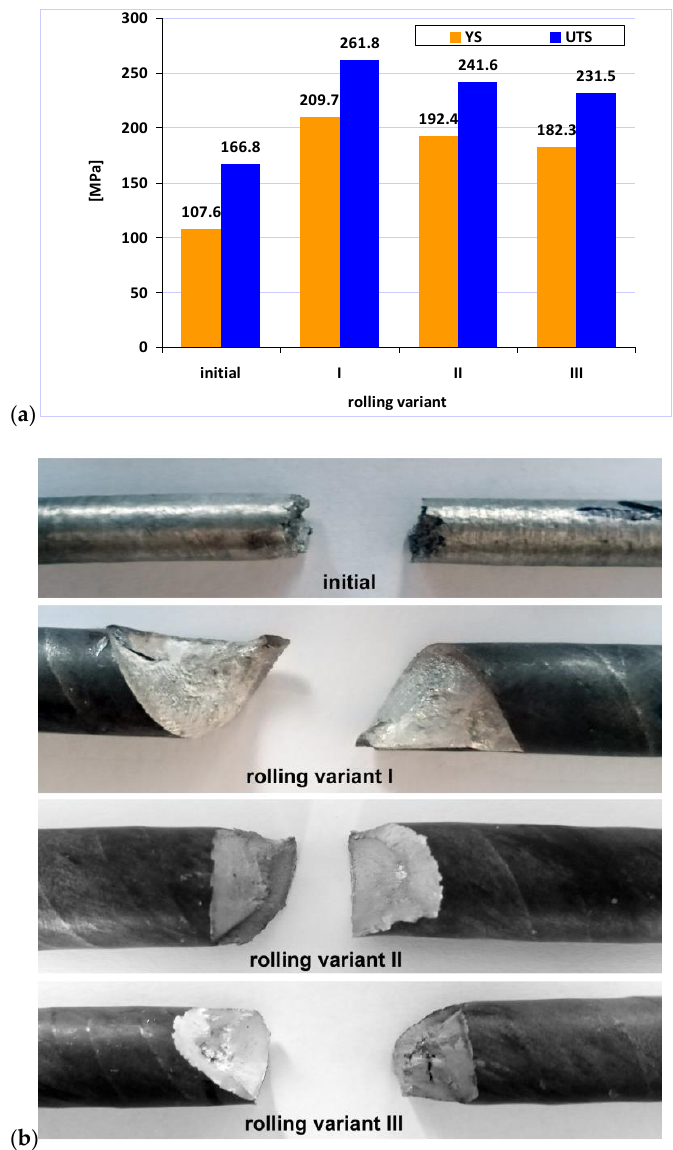
Figure 8. Mechanical properties of AZ31 magnesium alloy in the initial state and after the RSR process; ( a ) view of fractures in the samples after the tensile tests ( b ).